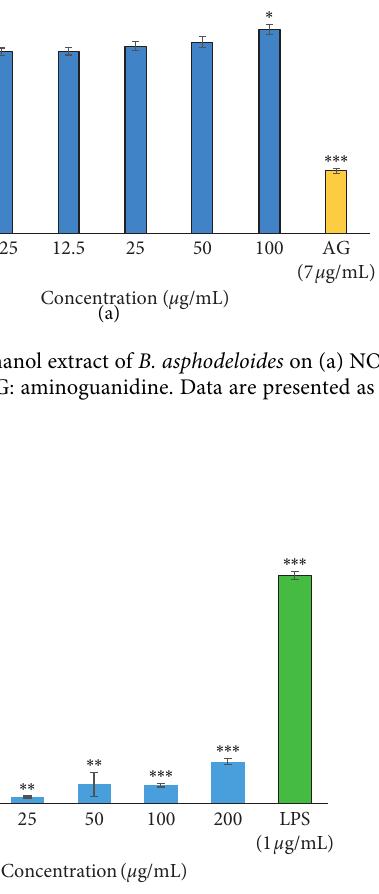
Figure 6: Immune-stimulatory potential of the ethanol extract of B. asphodeloides using RAW 264.7 cells. Previous experiment (anti- inflammatory assay) has confirmed the absence of toxicity. Data are presented as the mean ± SD ( n � 3). ∗ P < 0 . 05, ∗∗ P < 0 . 01, and ∗∗ ∗ P < 0 . 001 compared to the